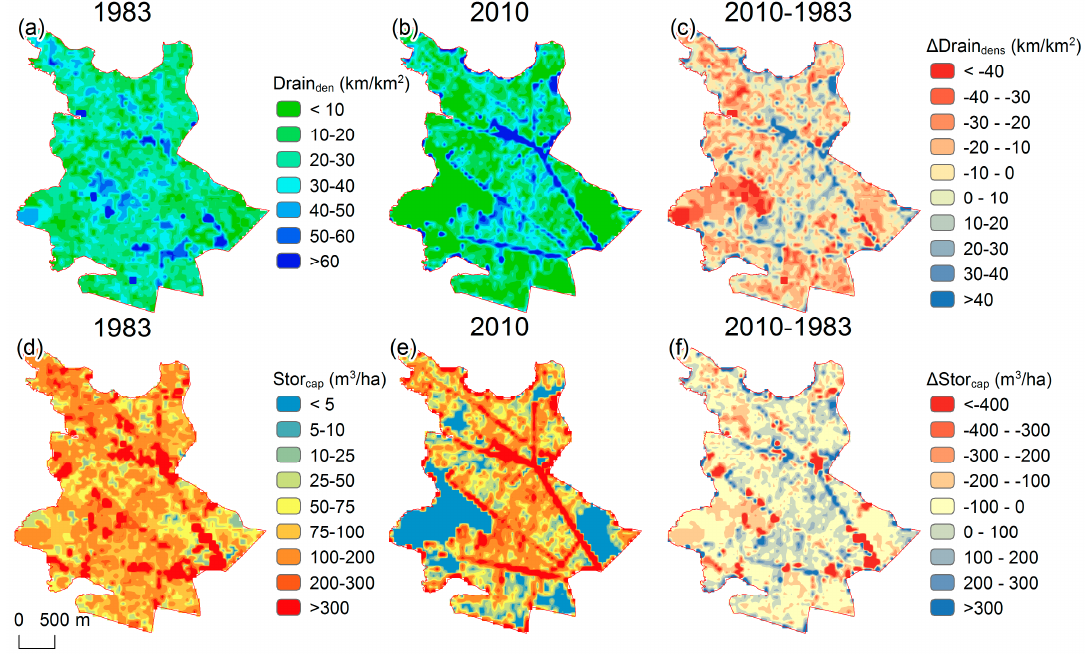
Figure 4. Drainage density (Drain den ) and Storage Capacity (Stor cap ) in 1983 and 2010, and relative differences.